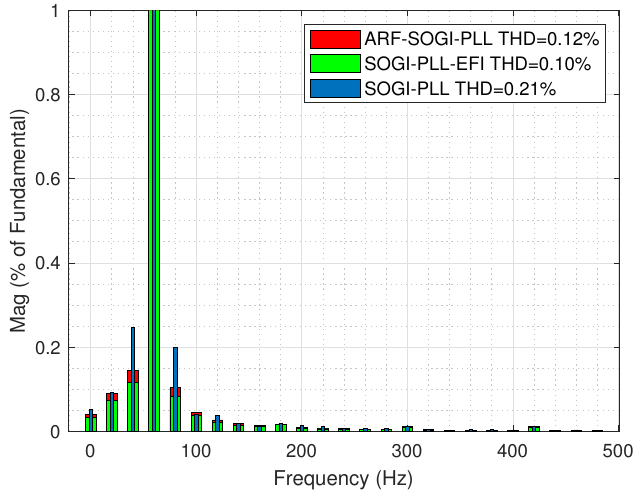
(cid:16) (cid:17) ω t (cid:48) for k αβ = 0.5 and k = 0.5 and an input THD of